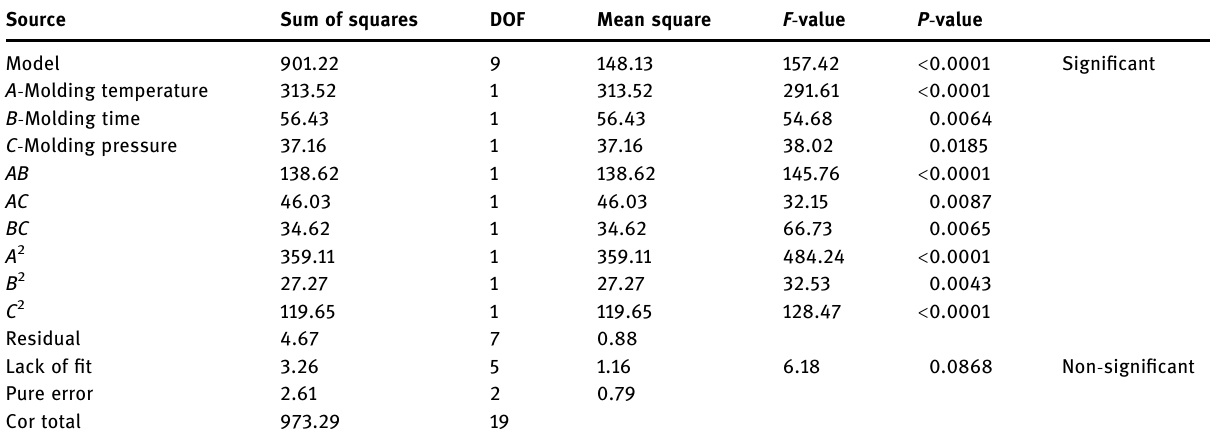
Table 9: ANOVA for compression modulus